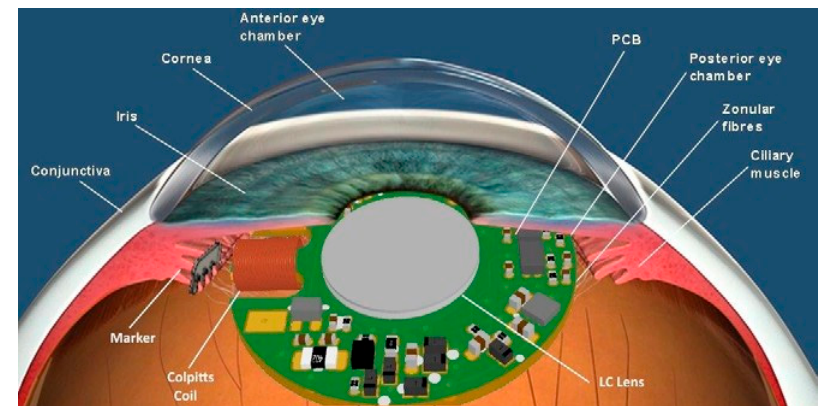
Figure 1. An illustration, based on Heidelberg engineering Eye-Anterior-Description of the developed implantable eye lens system.